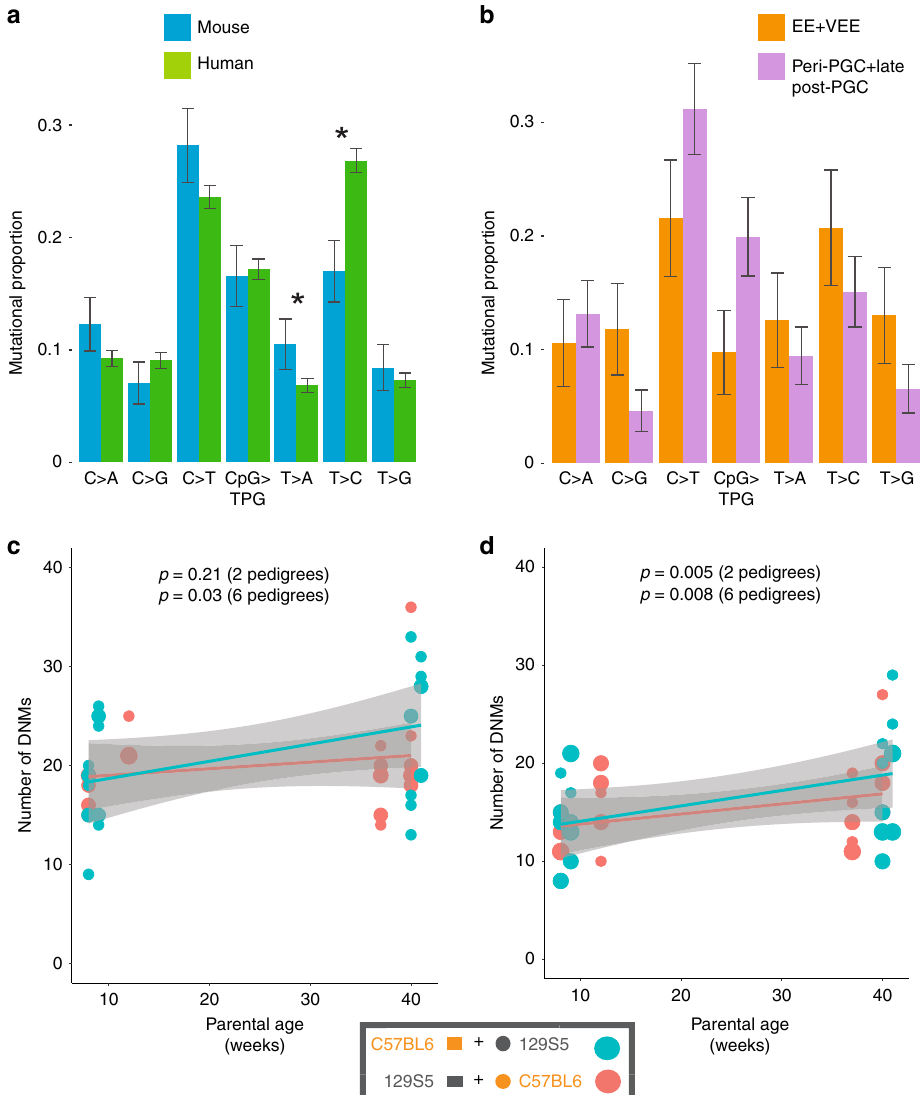
Fig. 4 Mutational spectra and paternal age effect of DNMs in mice. a Comparison of mutational spectra in mice and humans using a catalogue of compiled DNMs in humans 3 . Error bars are 95% con fi dence intervals. Stars show signi fi cance ( p < 0.05) after correction for multiple testing. The mouse data were derived from DNMs in 40 offspring from six pedigrees and the human data from 6570 DNMs from 109 trios 3 . b Comparison of mutational spectra in VEE + EE mutations compared to peri-PGC + late post-PGC mutations in mice. Effect of parental age on number of DNMs in individuals before ( c ) and after ( d ) removal of VEE mutations arising in offspring. The size of the plotting symbol indicates the number of individuals sharing the same number of mutations. p Values indicate the signi fi cance of the regression coef fi cients. The grey shading indicates the con fi dence limits on the regression. The mouse DNMs were derived from 40 offspring in six